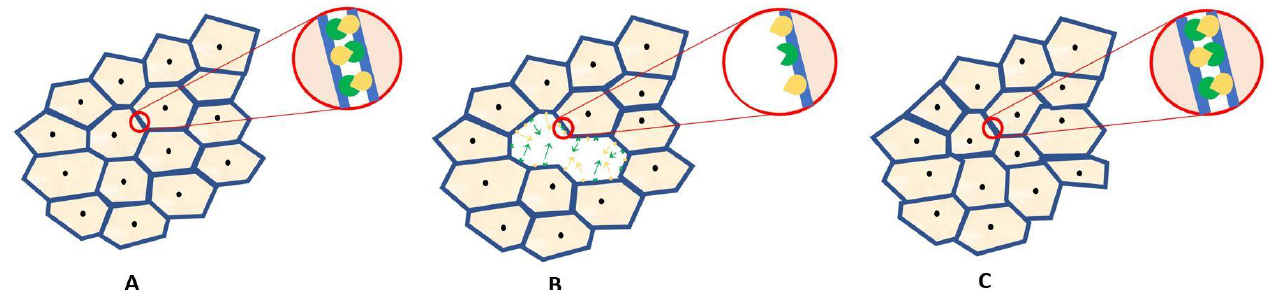
Figure 2. Diagram of the healing process of the corneal endothelium. ( A ) A healthy endothelium is made up of a single layer of hexagonal cells tightly adjacent to each other. ( B ) When cells are lost, spaces are created in the endothelial layer. The surrounding cells begin to migrate towards the lesion (green and yellow arrows). ( C ) When the healing process is complete, cells reattach to each other but lose their hexagonal shape and exhibit variability in size. Membrane-bound Eph and ephrins are expected to contribute to cell adherence and migration.